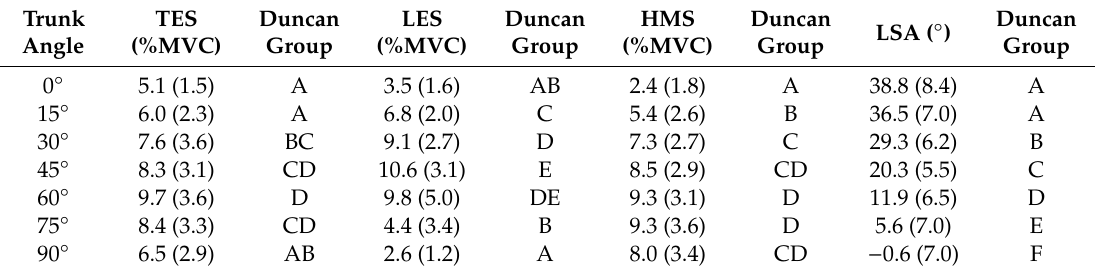
Table 5. Muscle activity and LSA of Duncan groups with varying trunk angles.